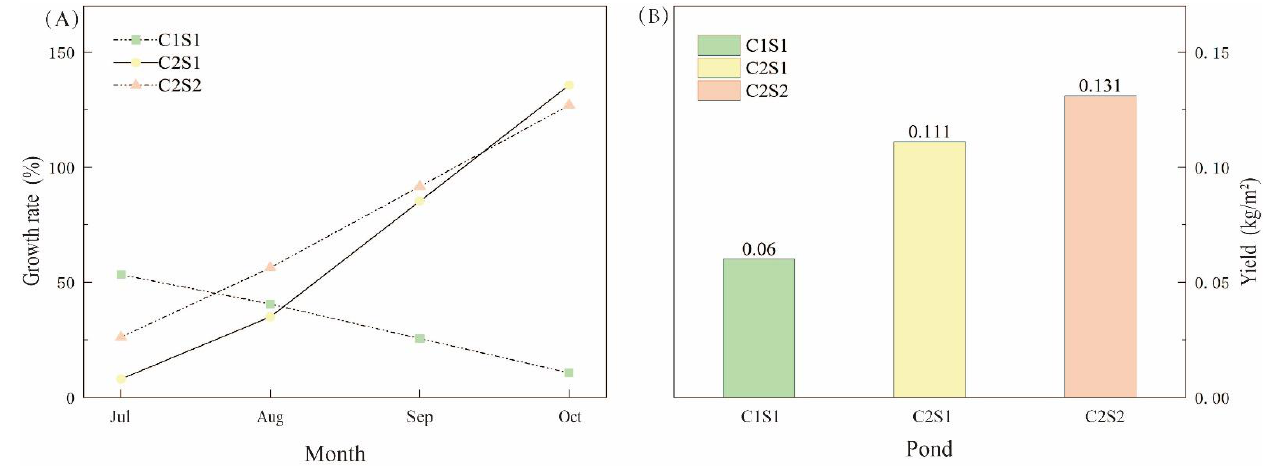
Figure 8. Growth-related traits of E. sinensis in different ponds ( A ) and yields of different ponds ( B ).